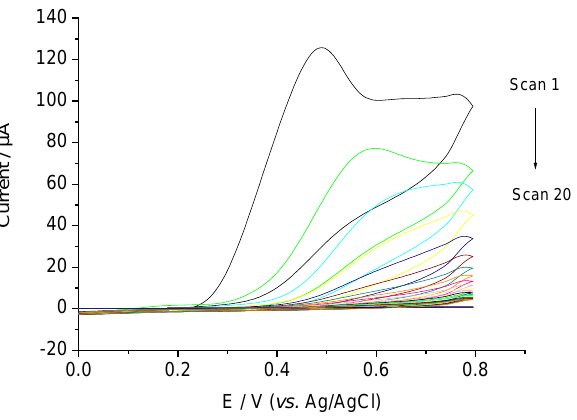
Figure 2. CVs showing formation of TAM-MIP.